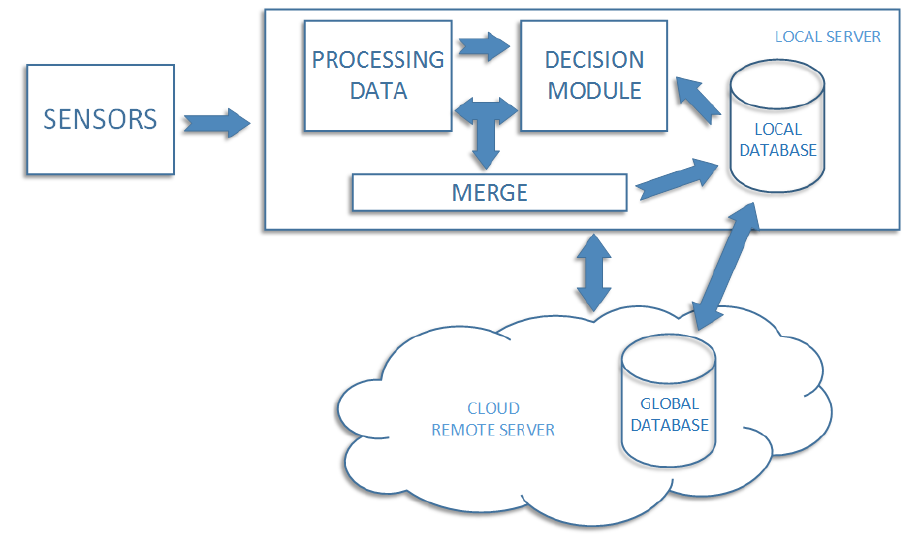
Figure 2. Diagram of information flow in the home management